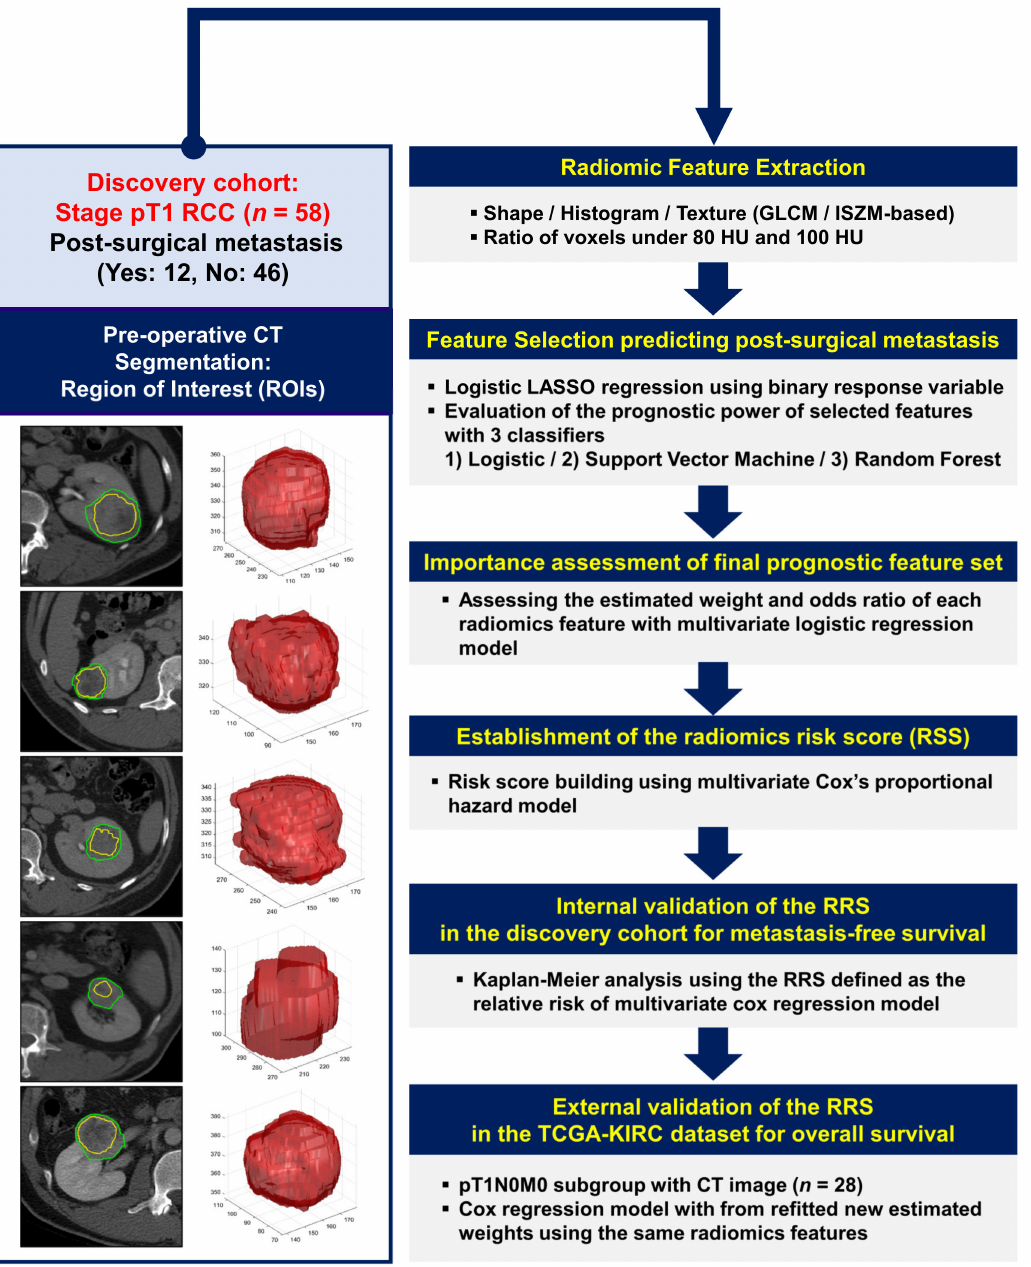
Figure 1. Workflow of radiomics analysis. Manual delineation of representative tumor regions of interest (ROIs) using preoperative computed tomography (CT) (left panel). Radiomic features based on the first- and second-order statistics and two semantic features were computed using inner and outer ROIs. Features associated with postsurgical metastasis in pathologic stage I renal cell carcinoma were selected using the logistic least absolute shrinkage and selection operator (LASSO), and their prognostic values were evaluated using three classifiers (right